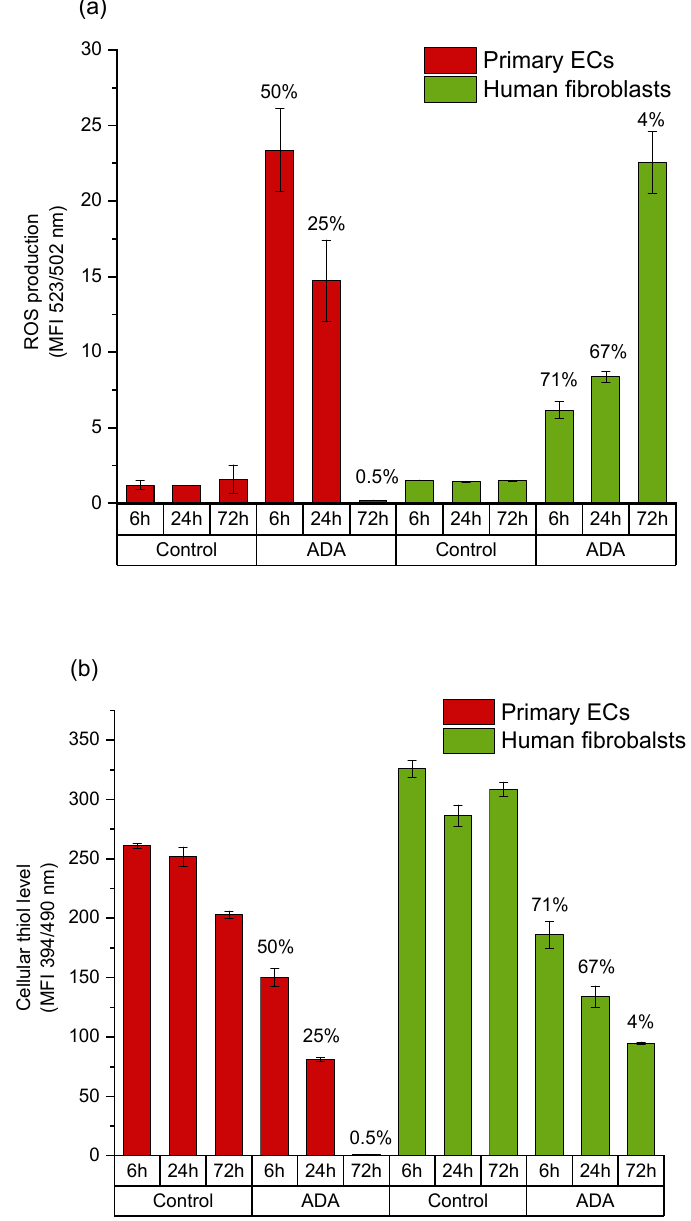
Figure 6. Comparison of intracellular reactive oxygen species (ROS) levels and cellular thiol levels in primary ECs and fibroblasts grown in a time dependent manner in ADA. ( a ) Mean value of DCF emission detected by flow cytometer; ( b ) intracellular thiol level of cells under the same conditions. Results obtained in the same cell population with MBB staining and mean value of emission are presented. Cell viability at respective time points is indicated above the columns. Control: cells with DCFH-DA grown on cell culture plastic.